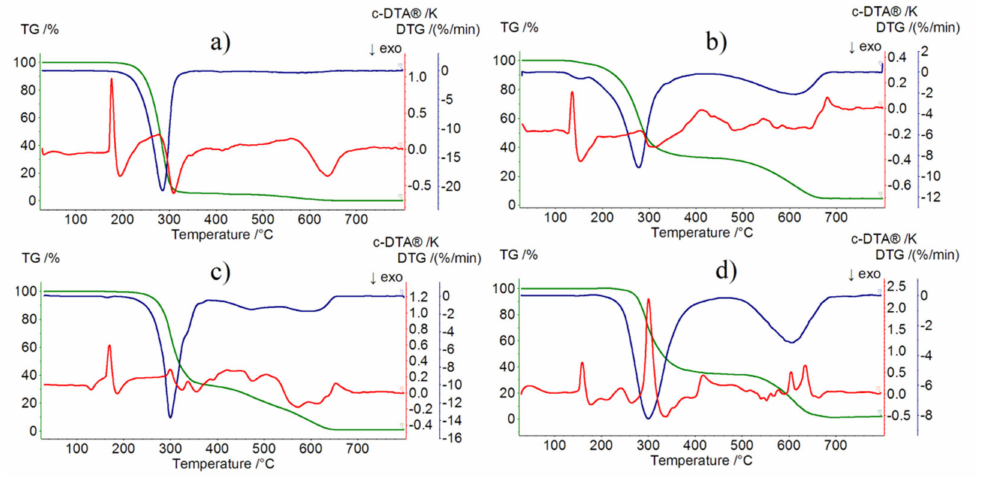
Figure 5. TG, DTG, and DTA curves of: ( a ) imipramine hydrochloride in air, ( b ) [HL] 2+ [CuCl 4 ] 2 − compound in air, ( c ) [HL] 2+ [ZnCl 4 ] 2 − compound in air, and ( d ) [HL] 2+ [CdCl 4 ] 2 − compound in air. [HL] 2+ [CuCl 4 ] 2 − compound begins to decompose at 130 ◦ C (Figure 5b). Its